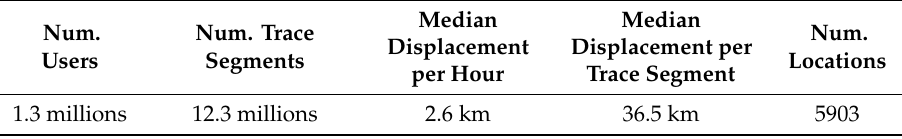
Table 1. Summary characteristics of the pre-processed